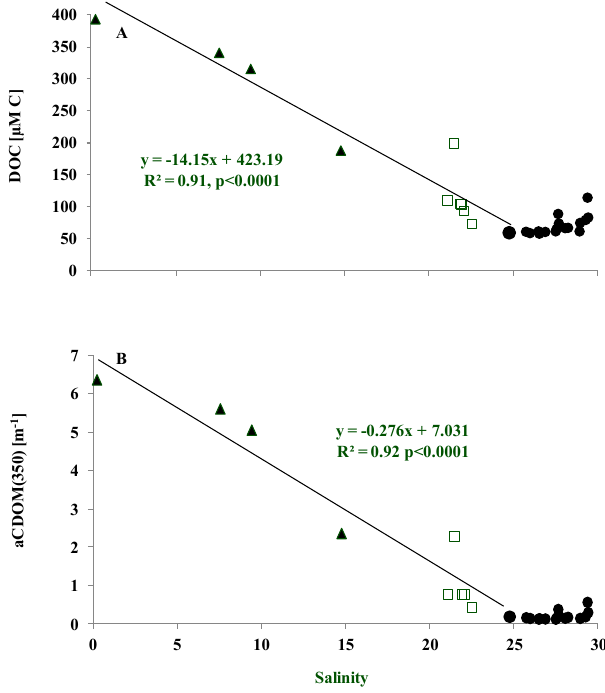
Fig. 4. Dissolved organic carbon (A) and spectral absorption co- Figure 4 . Dissolved organic carbon ( A ) and s p ectral absorption coefficients a CDOM (350) (B) as 743 efficients a CDOM (350) (B) as a function of surface salinity in the a function of surface salinity in the North East (circles), North West (squares) and Mackenzie 744 North East (circles), North West (squares) and Mackenzie Delta (tri- Delta (triangles) sectors. Linear regression s are given for the North West and Mackenzie delta 745 angles) sectors. Linear regressions are given for the North West and Mackenzie Delta sectors . 746 747